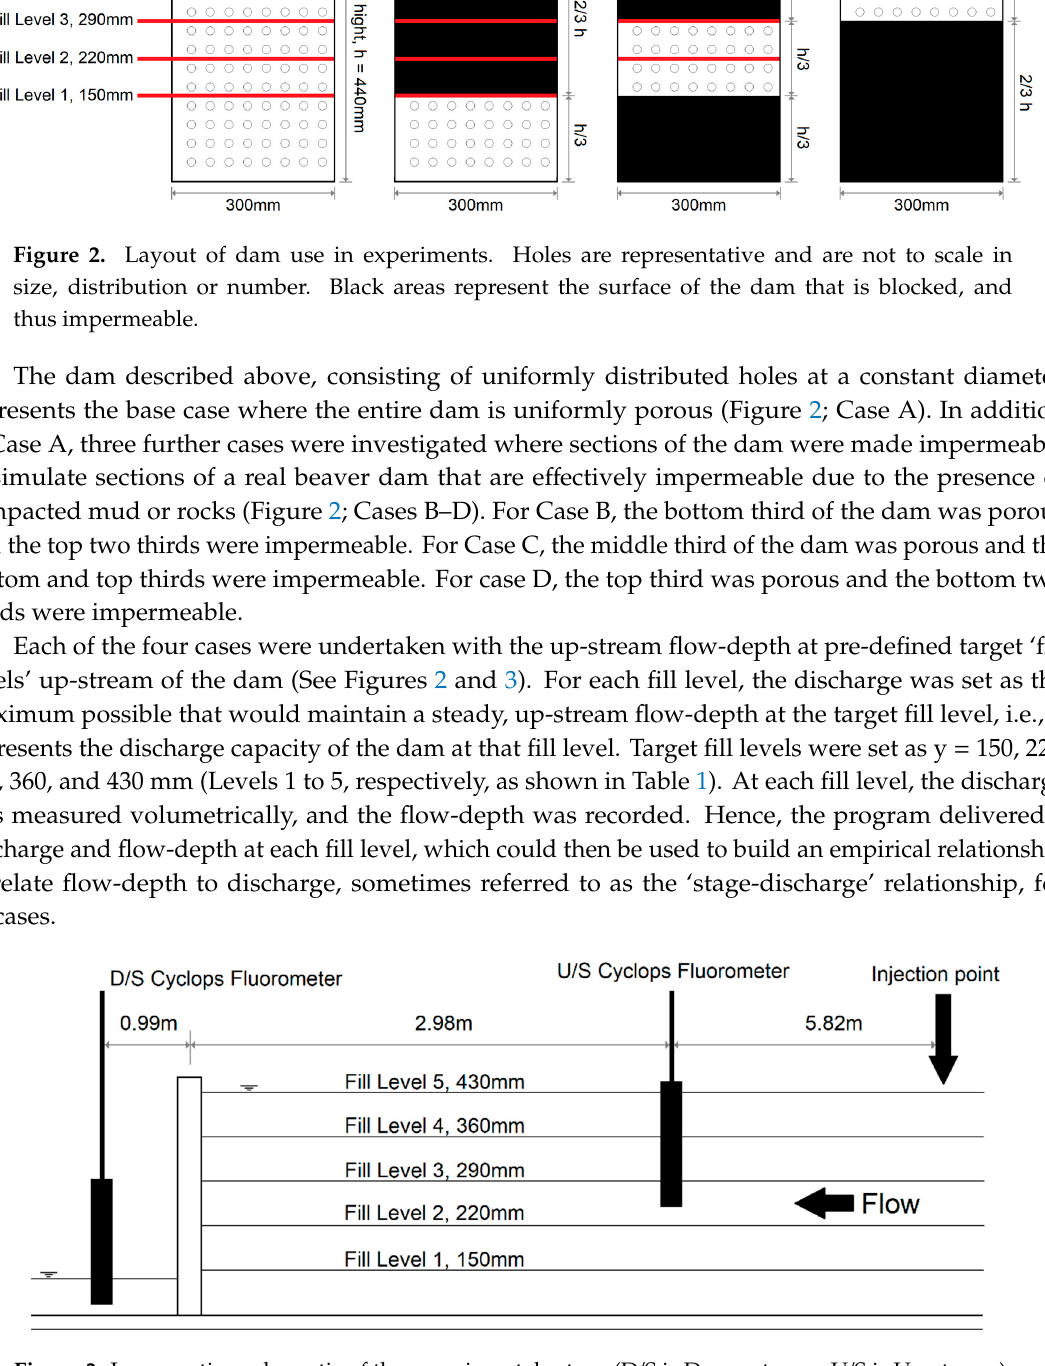
Figure 3. Long-section schematic of the experimental set-up (D/S is Down-stream; U/S is Up-stream).